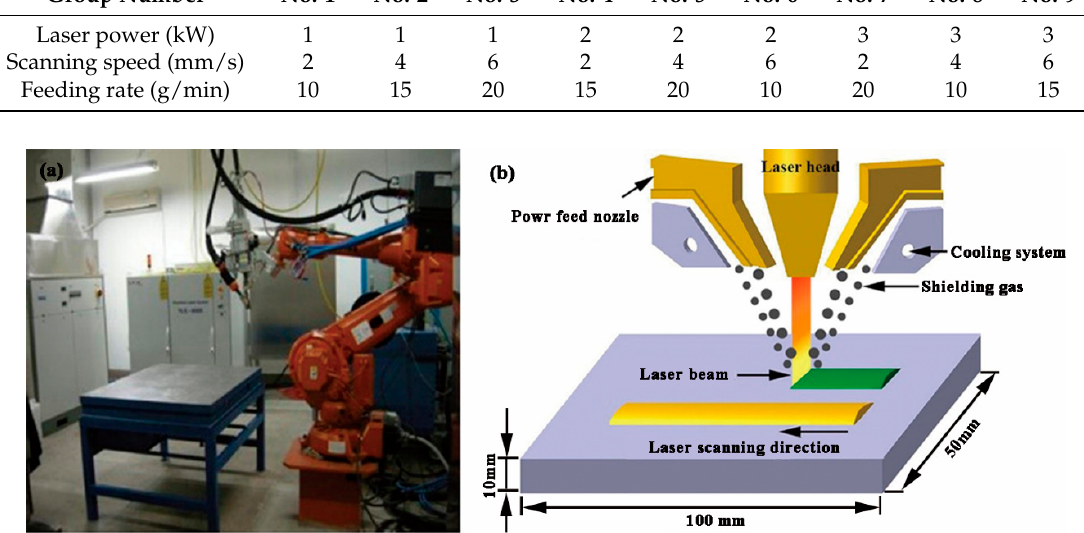
Figure 2. Experimental setup: ( a ) overall experimental setup; ( b ) schematic of laser cladding process.